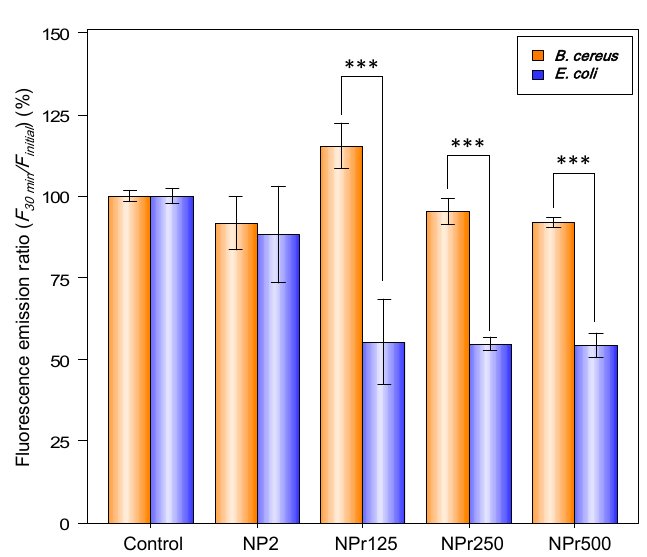
Figure 3. ( A ) Zeta potential distribution of bacterial cells of B. cereus and E. coli , C4 (31.25 µg/mL), C5 (15.63 µg/mL), C6 (7.81 µg/mL); ( B ) Detection of biofilm production on NB Congo red agar plate (clockwise from the left were B. subtilis , B. pumilus , B. amyloliquefaciens , B. cereus , and E. coli ); ( C ) The release of cell contents identified by absorption at 260 nm from E. coli and B. cereus by treatment with protamine (125 µg/mL), chitosan (125 µg/mL), NP2 (250 µg/mL), NPr1 (250 µg/mL); ( D ) The binding (30 min)-to-initial (0 min) fluorescence emission ratio ( F 30 min / F initial ) of E. coli and B. cereus treated with NP2 and NPr (125, 250, and 500 µg/mL) ; *** means p <0.001.